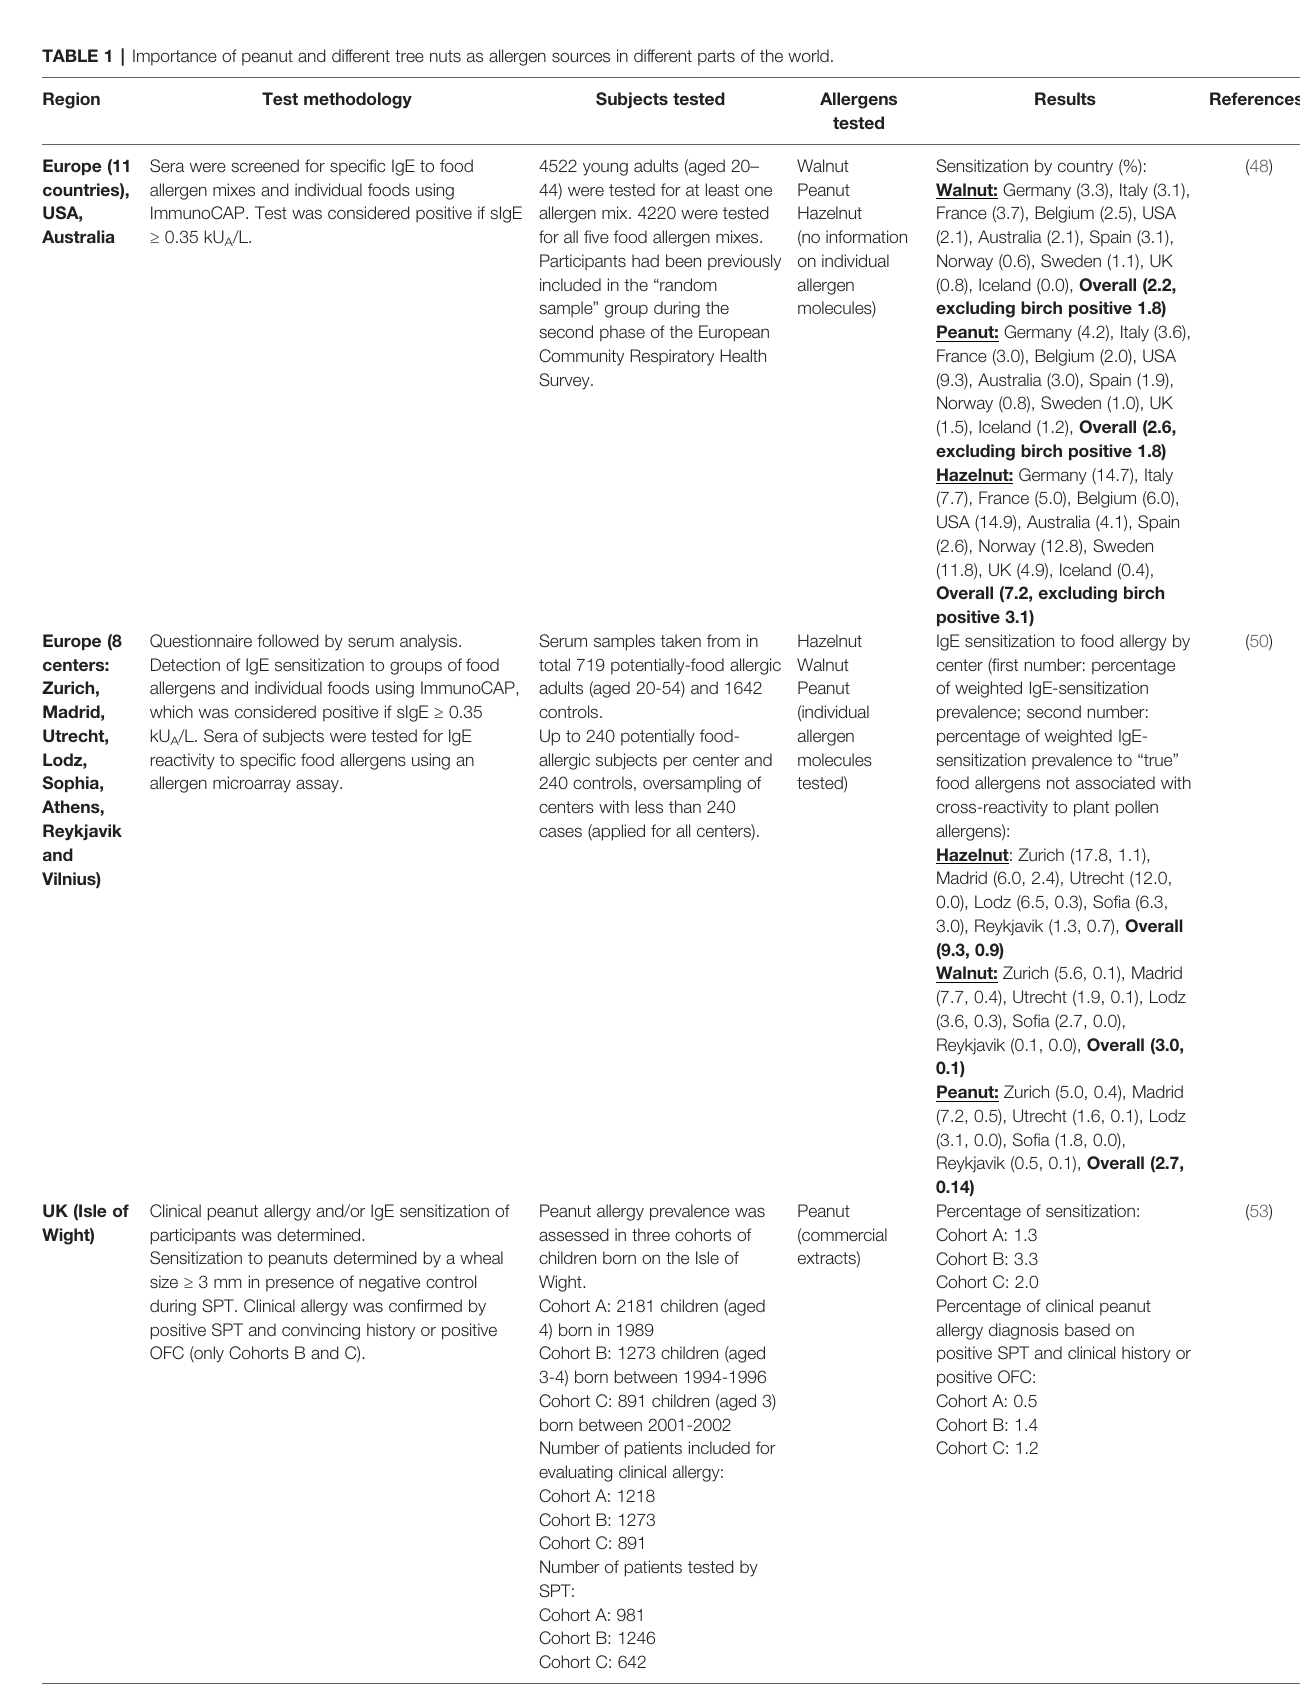
TABLE 1 | Importance of peanut and different tree nuts as allergen sources in different parts of the world.